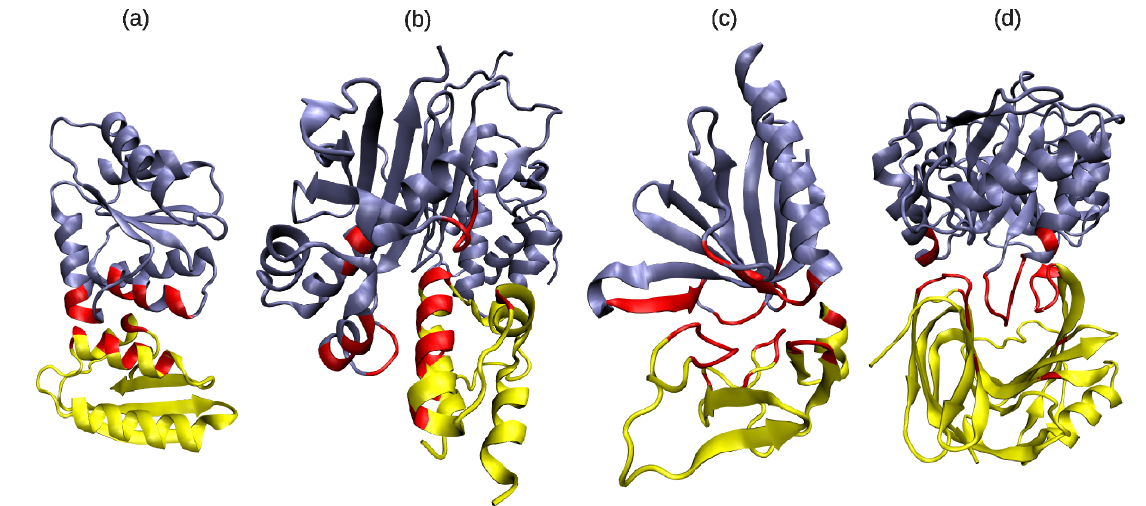
Examples of DDIs involving various SSE class pairs: ( a ) α -rich with α -rich (PDB code 1VRC, chains A, C); ( b ) α -rich with α + γ (PDB code 2CG5, chains A,